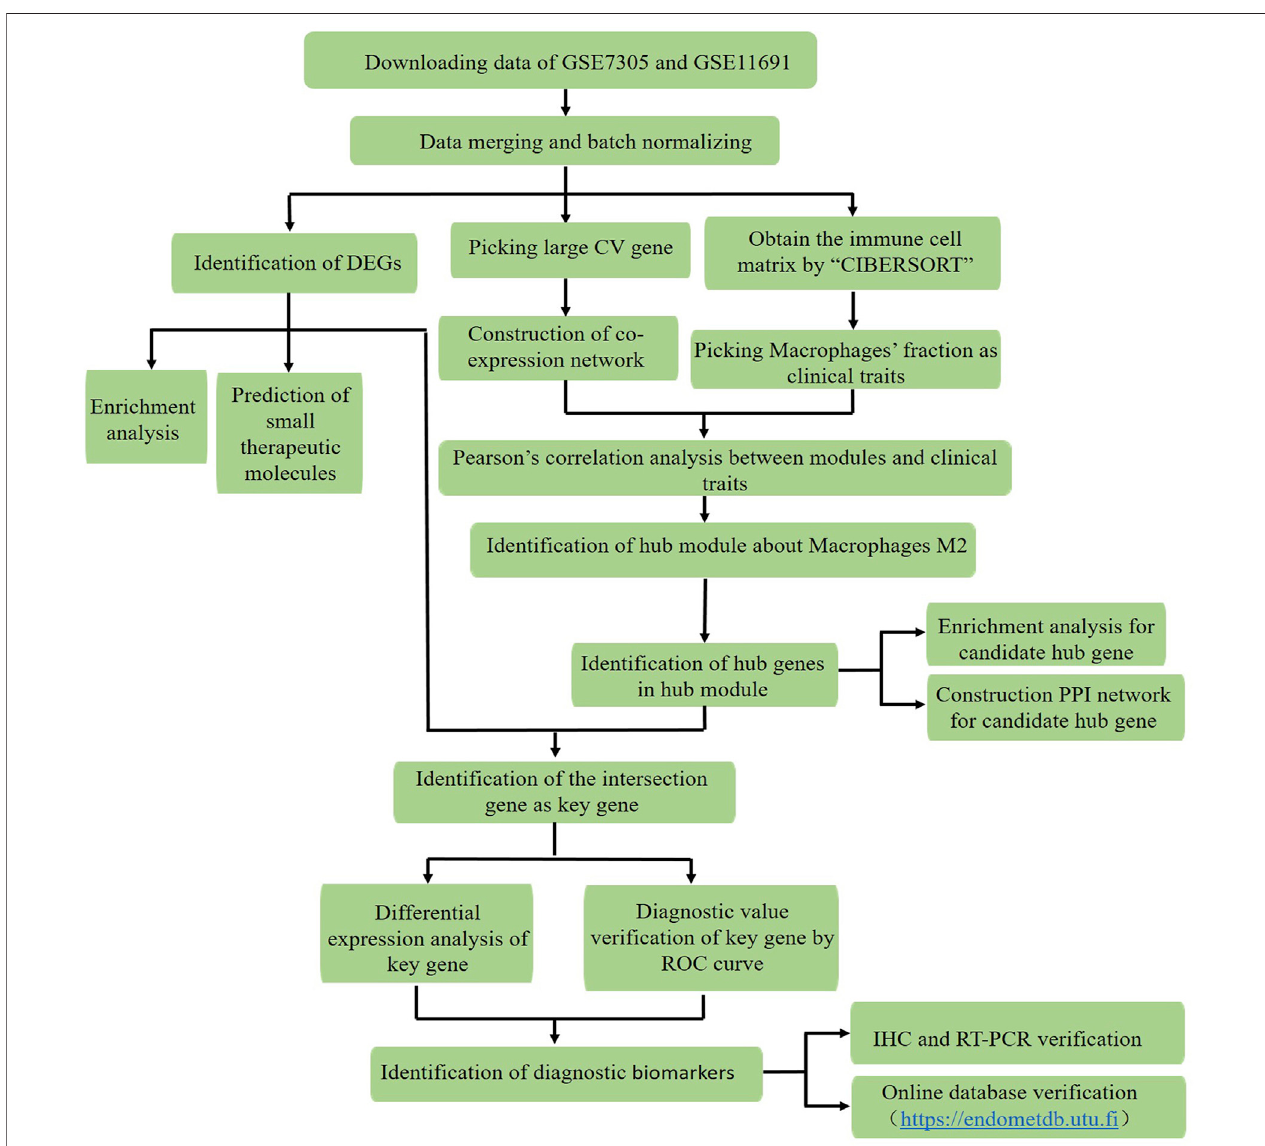
FIGURE 1 | Work fl ow for identi fi cation of the novel macrophage M2-related biomarkers through the CIBERSORT and WGCNA algorithms, and exploration of potentialtherapeuticagentsinendometriosisbyusingdatadownloadedfromtheGEOdatabase(CV:distinctvariantgenesexpressedin19endometriosissampleswith coef fi cient values > 0.1; DEGs: differentially expressed genes, ROC curve: receiver operating characteristic curve, IHC: immunohistochemistry, and RT-PCR: reverse transcription polymerase chain reaction).